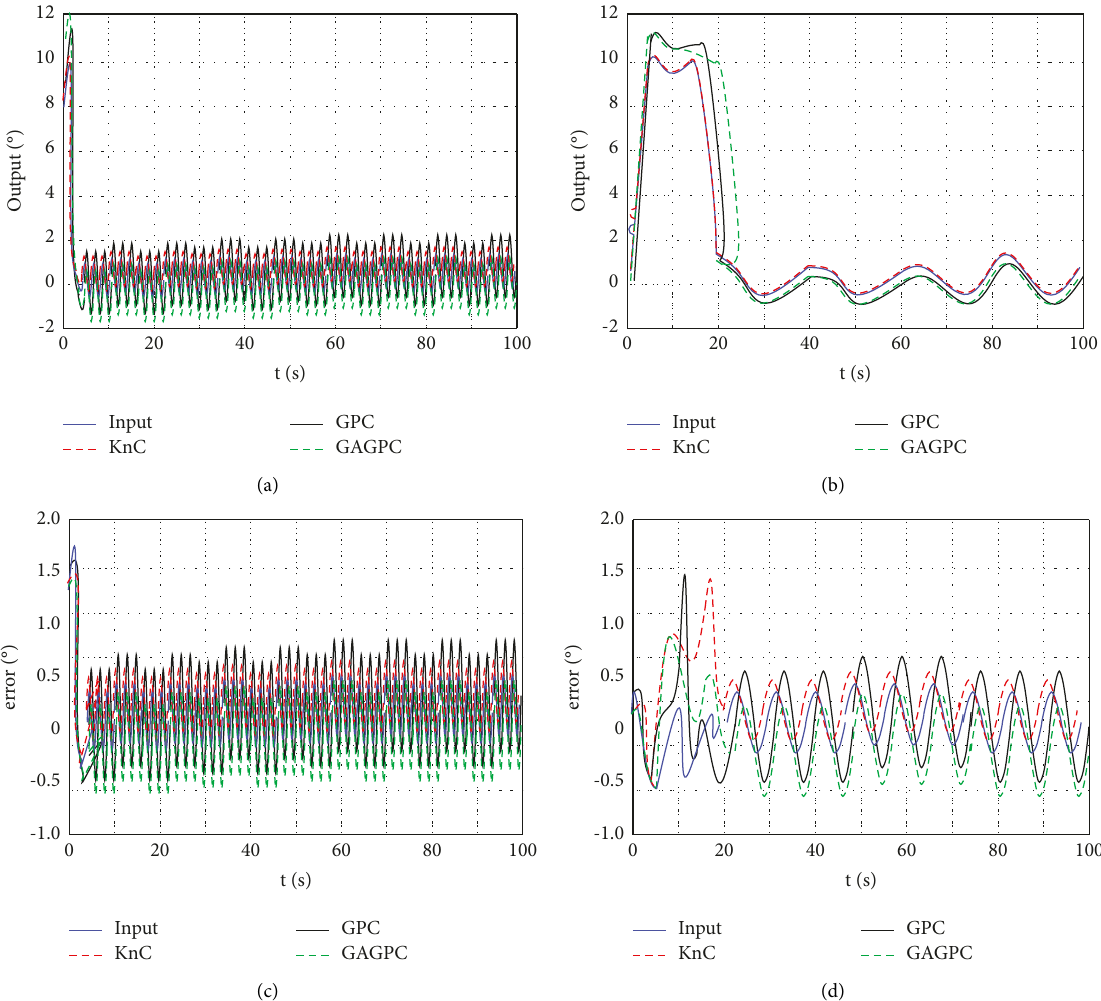
Figure 9: Tracking and error curves of stable platform under disturbance conditions. (a) Tracking curve. (b) Local magnification curve. (c) Deviation curve. (d) Local magnification